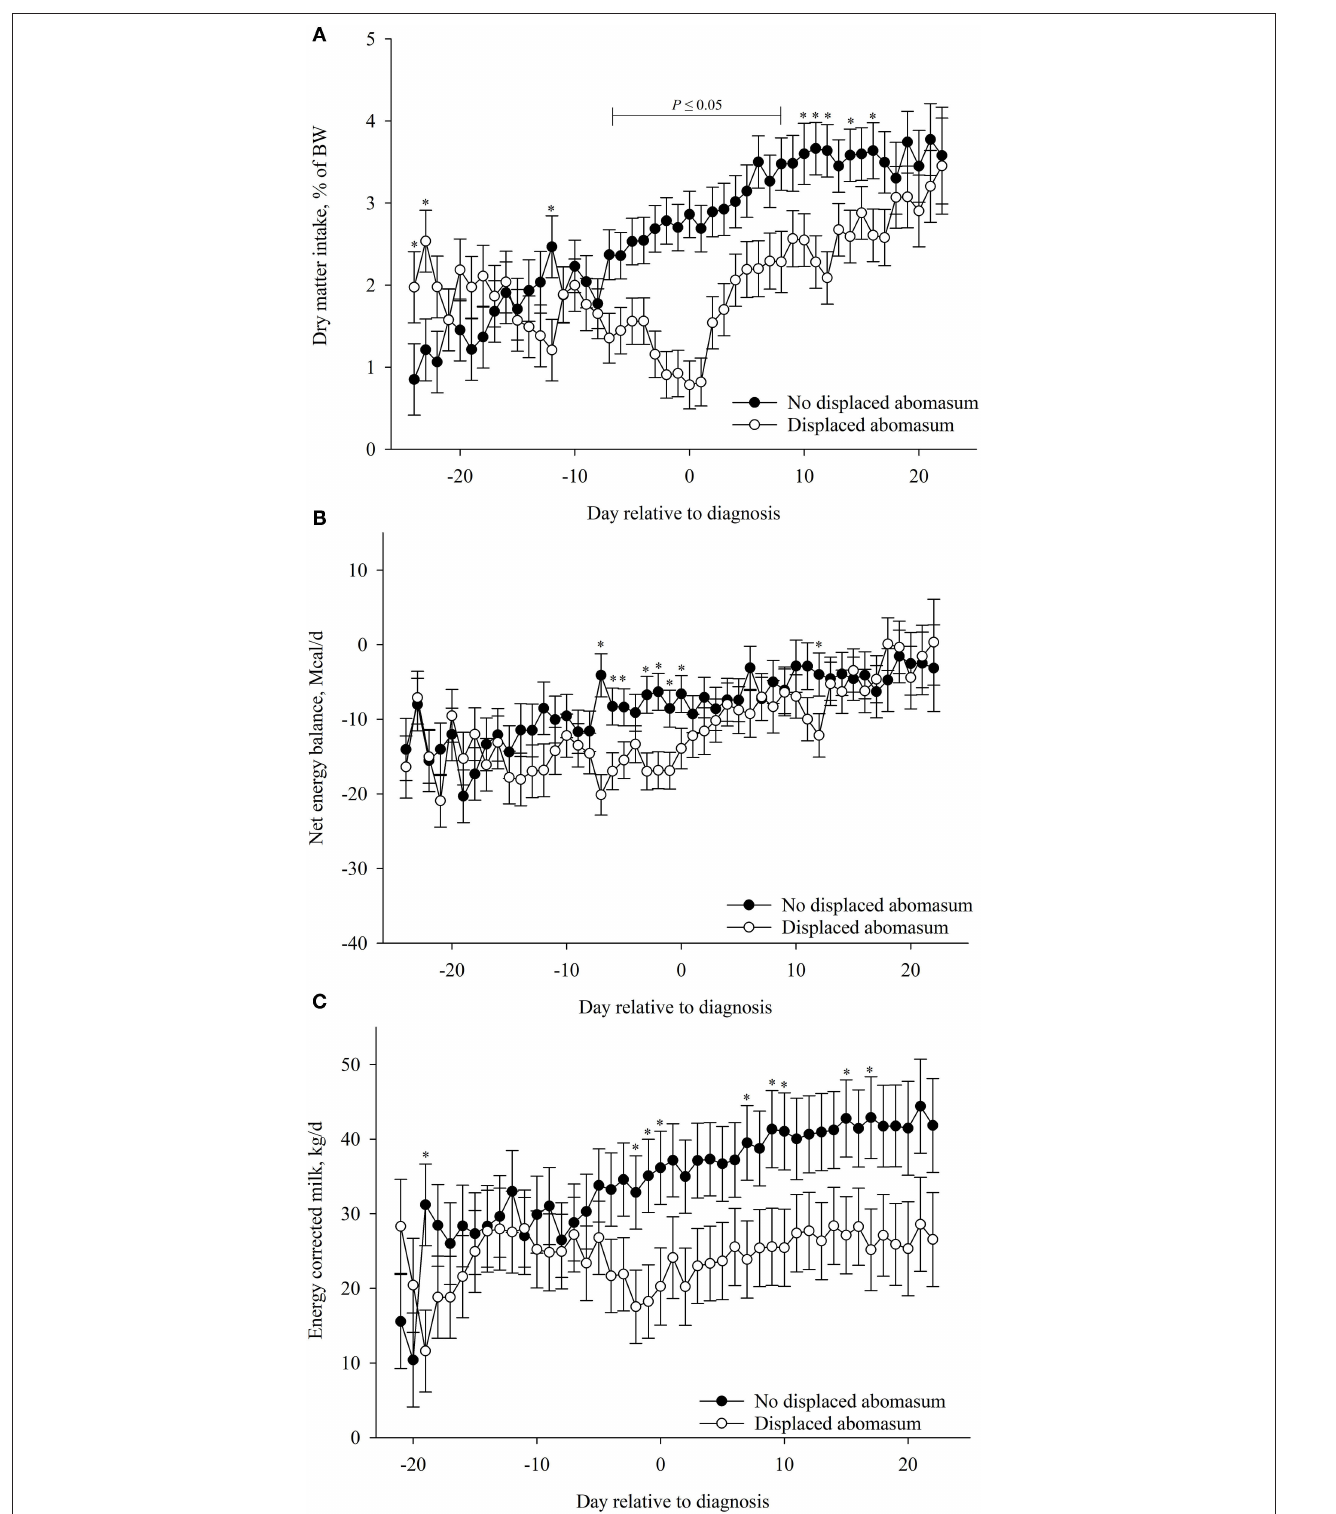
FIGURE 3 | Association of left displaced abomasum postpartum ( n = 26) with (A) dry matter intake (DMI, %BW), (B) net energy balance (EB, Mcal/day), and (C) energy-corrected milk (ECM, kg/day) during the postpartum period (from − 24 to 22 days relative to diagnosis). Values are least square means ± SEM. Postpartum DMI (%BW): left displaced abomasum, p = 0.11; day relative to parturition, p < 0.01; and the interaction between left displaced abomasum and day, p < 0.01. Postpartum EB: left displaced abomasum, p = 0.28; day relative to parturition, p < 0.01; and the interaction between left displaced abomasum and day, p < 0.01. ECM: left displaced abomasum, p = 0.17; day relative to parturition, p < 0.01; and the interaction between left displaced abomasum and day, p < 0.01. * p ≤ 0.05.